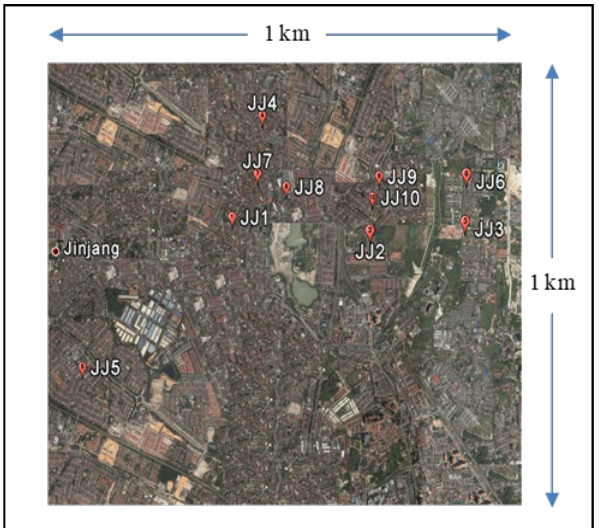
Figure 4. The locations of these GPS control